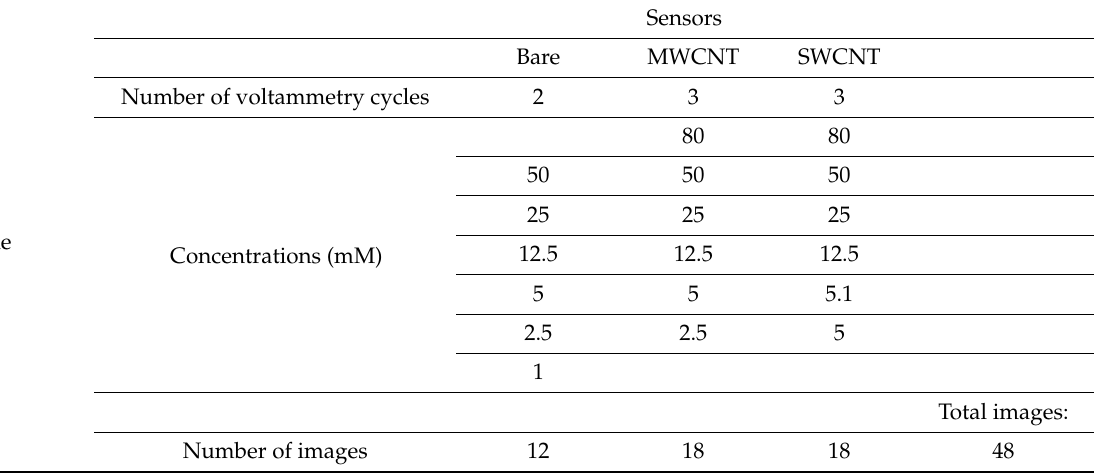
Table 3. Available dataset after cv